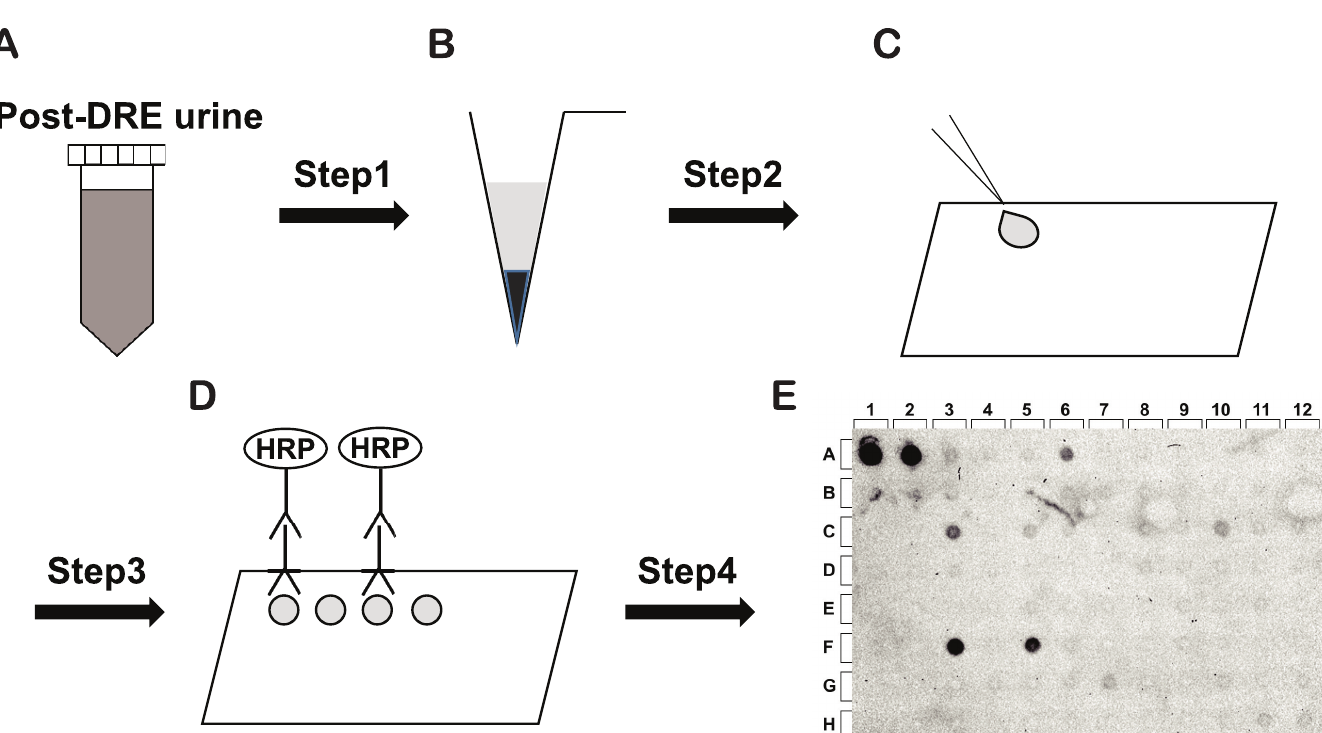
Fig 2. Detection of core2 β -1,6- N -acetylglucosaminyltransferase-1 in post-digital rectal examination urine specimens. ( A ) Post-digital rectal examination urine specimens were collected and ( B ) centrifuged. ( C ) Supernatants were collected and spotted onto a nitrocellulose membrane. ( D ) Core2 β - 1,6- N -acetylglucosaminyltransferase-1 (GCNT1) was detected by an anti-GCNT1 monoclonal antibody, followed by a horseradish peroxidase (HRP)- conjugated antibody. ( E ) After treatment with a chemiluminescence reagent, the GCNT1 signal was recorded by a ChemiDoc+ system.